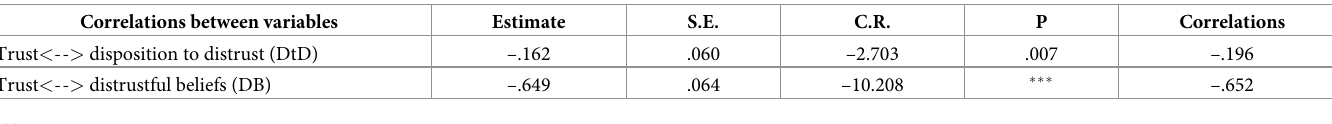
Table 15. Correlations between variables trust and distrust components. Correlations between